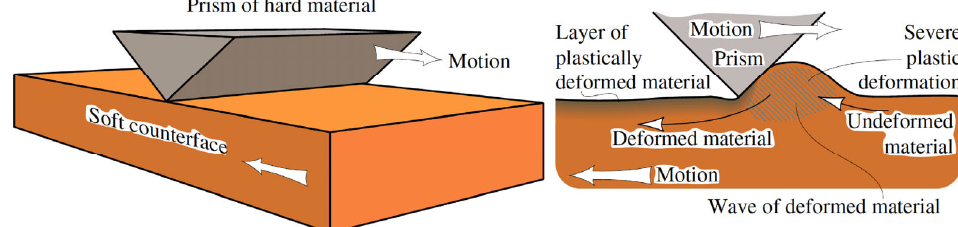
Fig. 3 Model of surface waves formation (adapted from Ref.